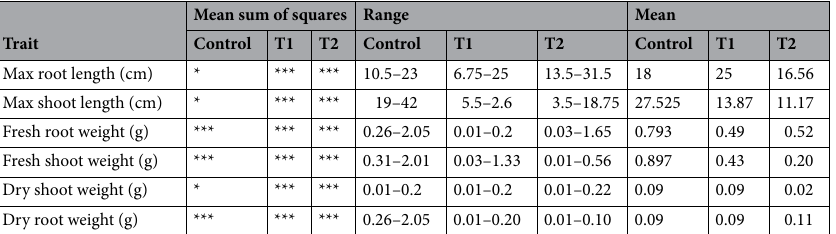
Table 6. Analysis of variance for seedling traits under control and variable WDS condition. T1: 15% PEG6000 and T2: 20% PEG6000. *Significant at 5% level of significance; ***significance at 1% level of significance.